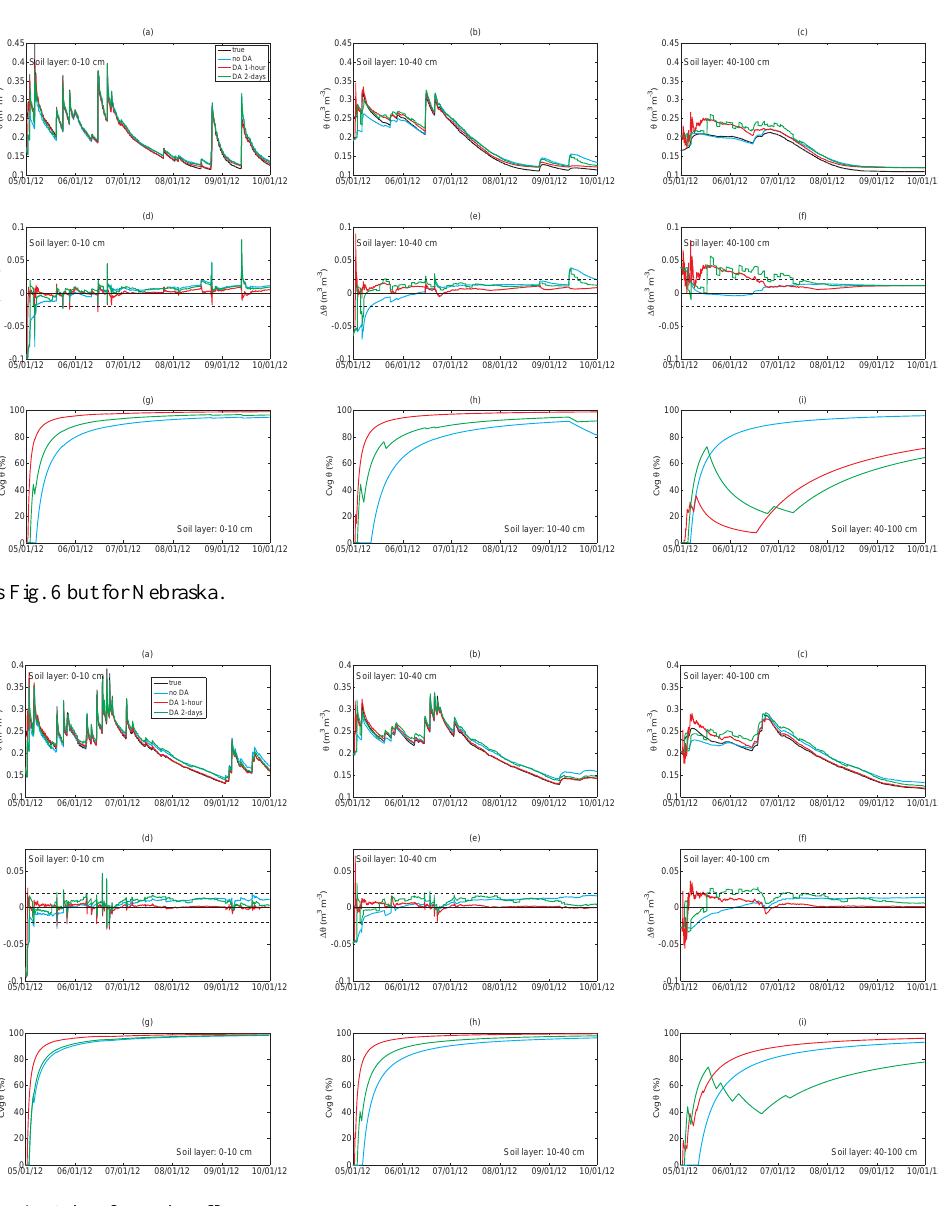
Figure 8. Same as Fig. 6, but for Park